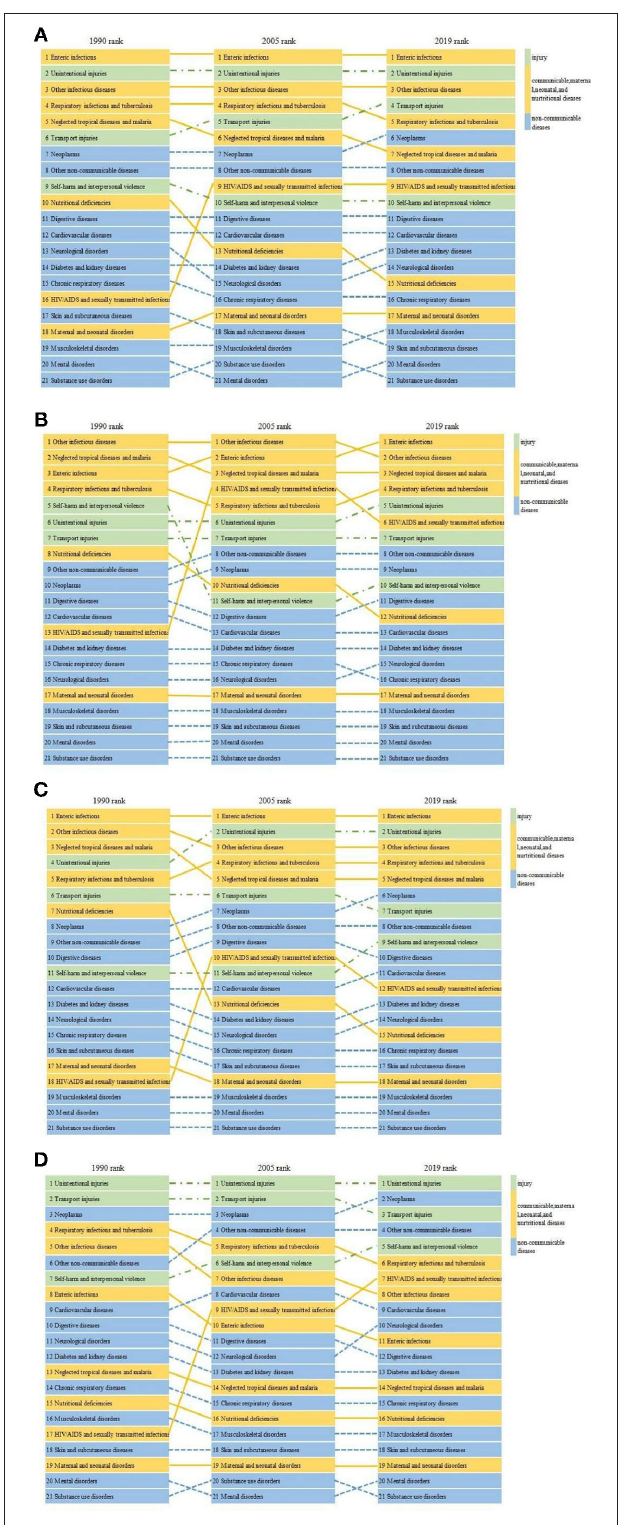
FIGURE 2 | Changes in the rank of causes of death in children aged 5–14 years globally (A) and in low-income countries (B) , lower middle-income countries (C) , and upper middle-income countries (D) from 1990 to